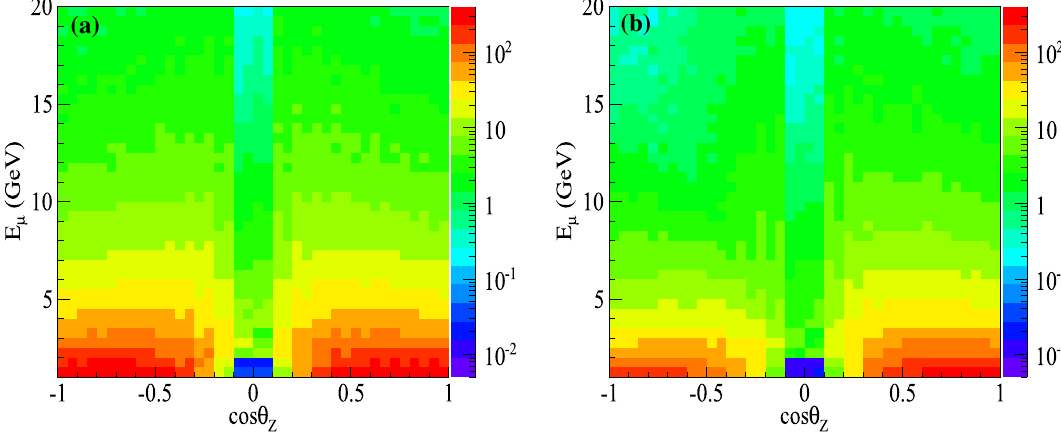
Fig. 4 The ratio of oscillated to unoscillated events as a function of neutrino ( black solid lines ) and muon ( red dashed lines ) energy. The cos θ z bin chosen is 0.30–0.35, θ 14 = θ 34 = 0, sin 2 2 θ 24 = 0 . 083